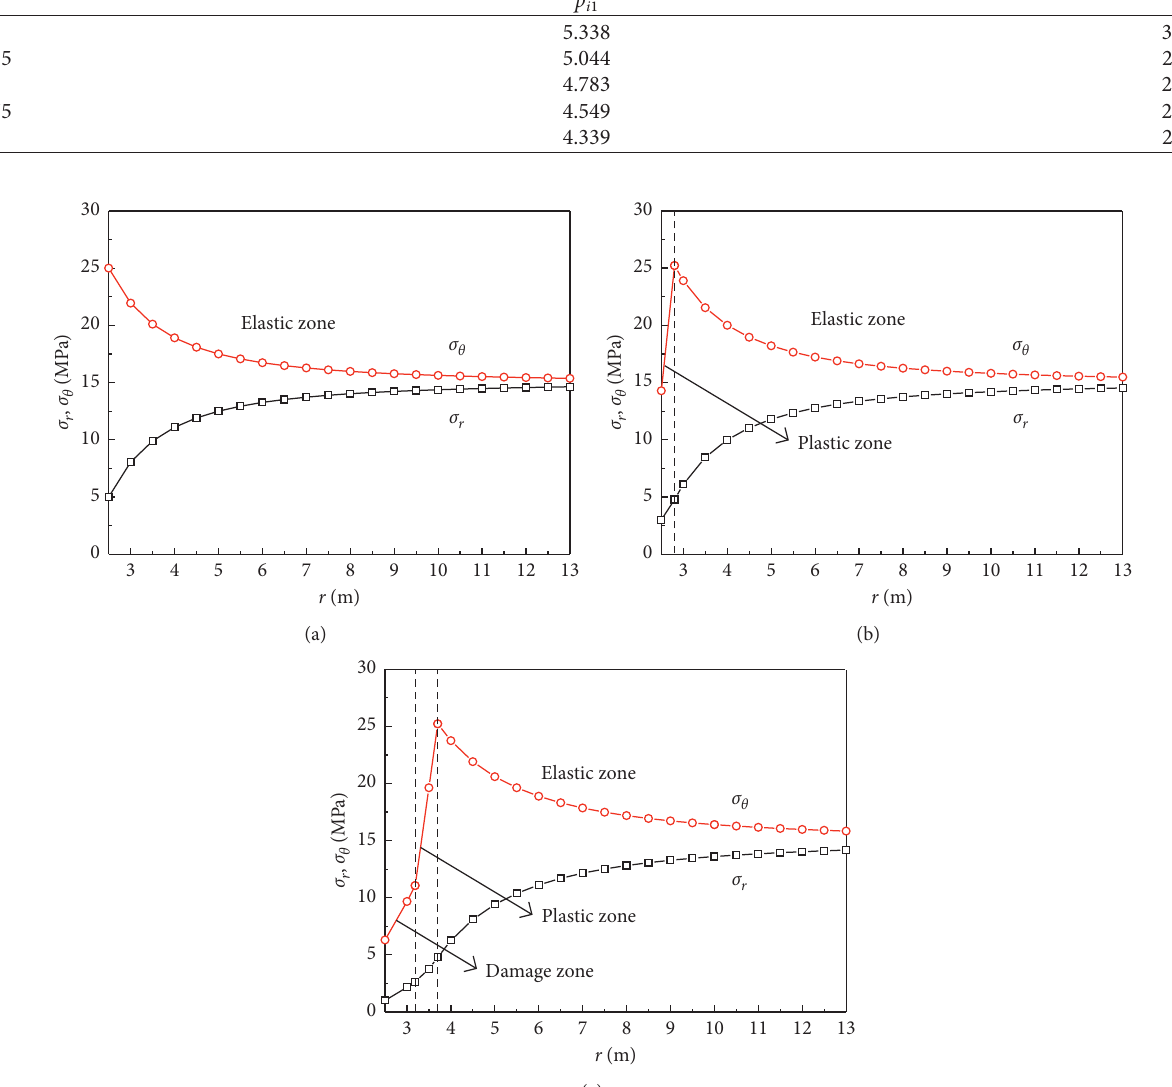
� 5 MPa, (b) p � 3 MPa, and (c) p i i